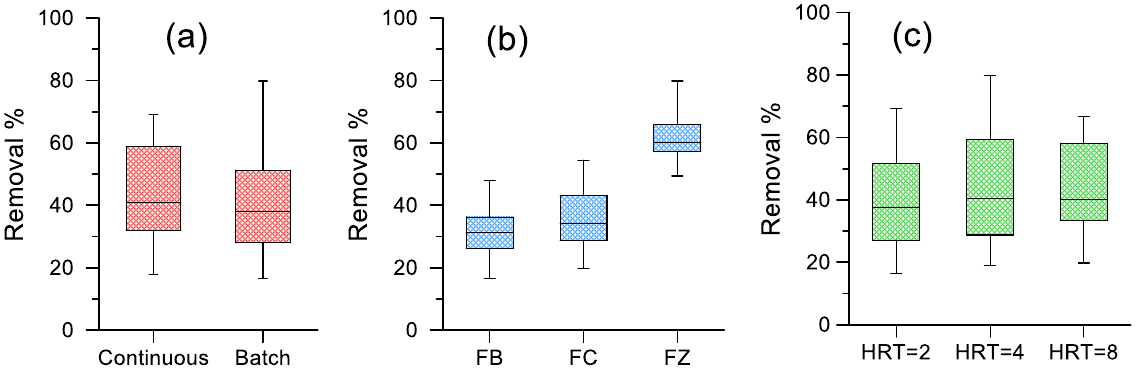
Figure 5. Effect of design parameters on pyraclostrobin removal in gravity filters: ( a ) feeding strategy; ( b ) porous media; ( c ) hydraulic residence time.